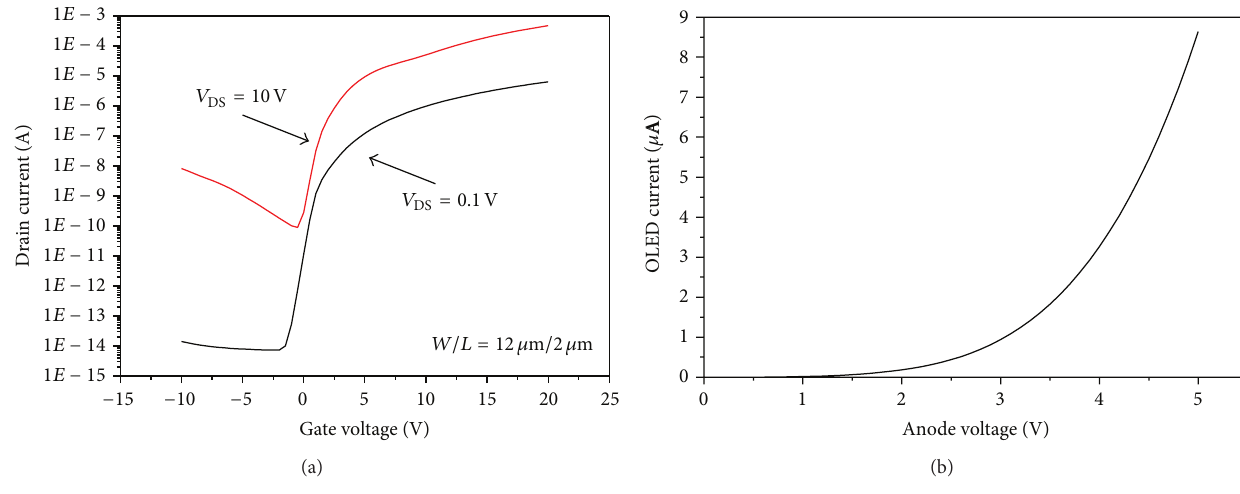
Figure 4: (a) The simulated 𝐼